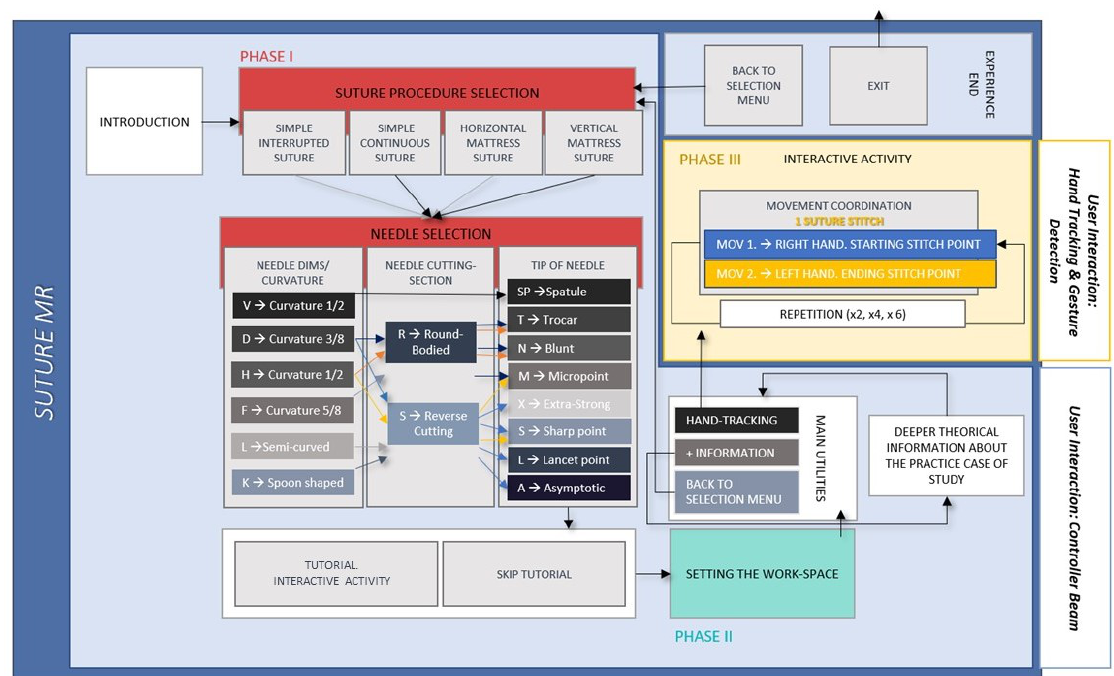
Figure 1. Suture MR UX workflow. The diagram shows user experience design of Suture MR detailing the selection content of each phase. Phase I (red color) enables needle selection, allowing different needle configurations (indicated by colored arrows), and finally, suture procedure selection; phase II (green color) enables set the workspace; and phase III (yellow color) consists of practicing the interactive